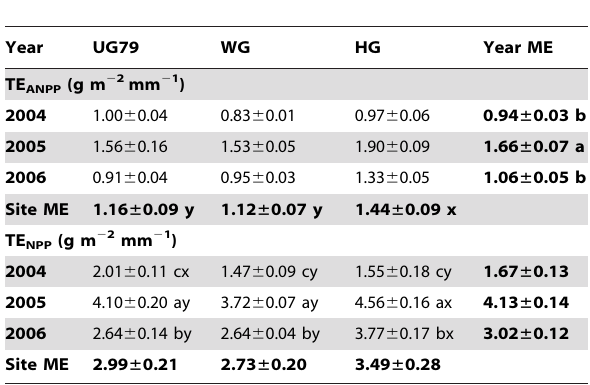
Figure 3. Relationship between RUE ANPP (g m 2 2 mm 2 1 ) and TE ANPP (g m 2 2 mm 2 1 ). Site UG79 (A), site WG (B), and site HG (C). The data for each site were from 2004, 2005 and 2006. The regression equations for UG79: y=0.040 + 0.438 x, r 2 =0.9446, n=15, P , 0.001; WG: y=0.024 + 0.393 x, r 2 =0.9387, n=15, P , 0.001; HG: y=0.160 + 0.158 x,